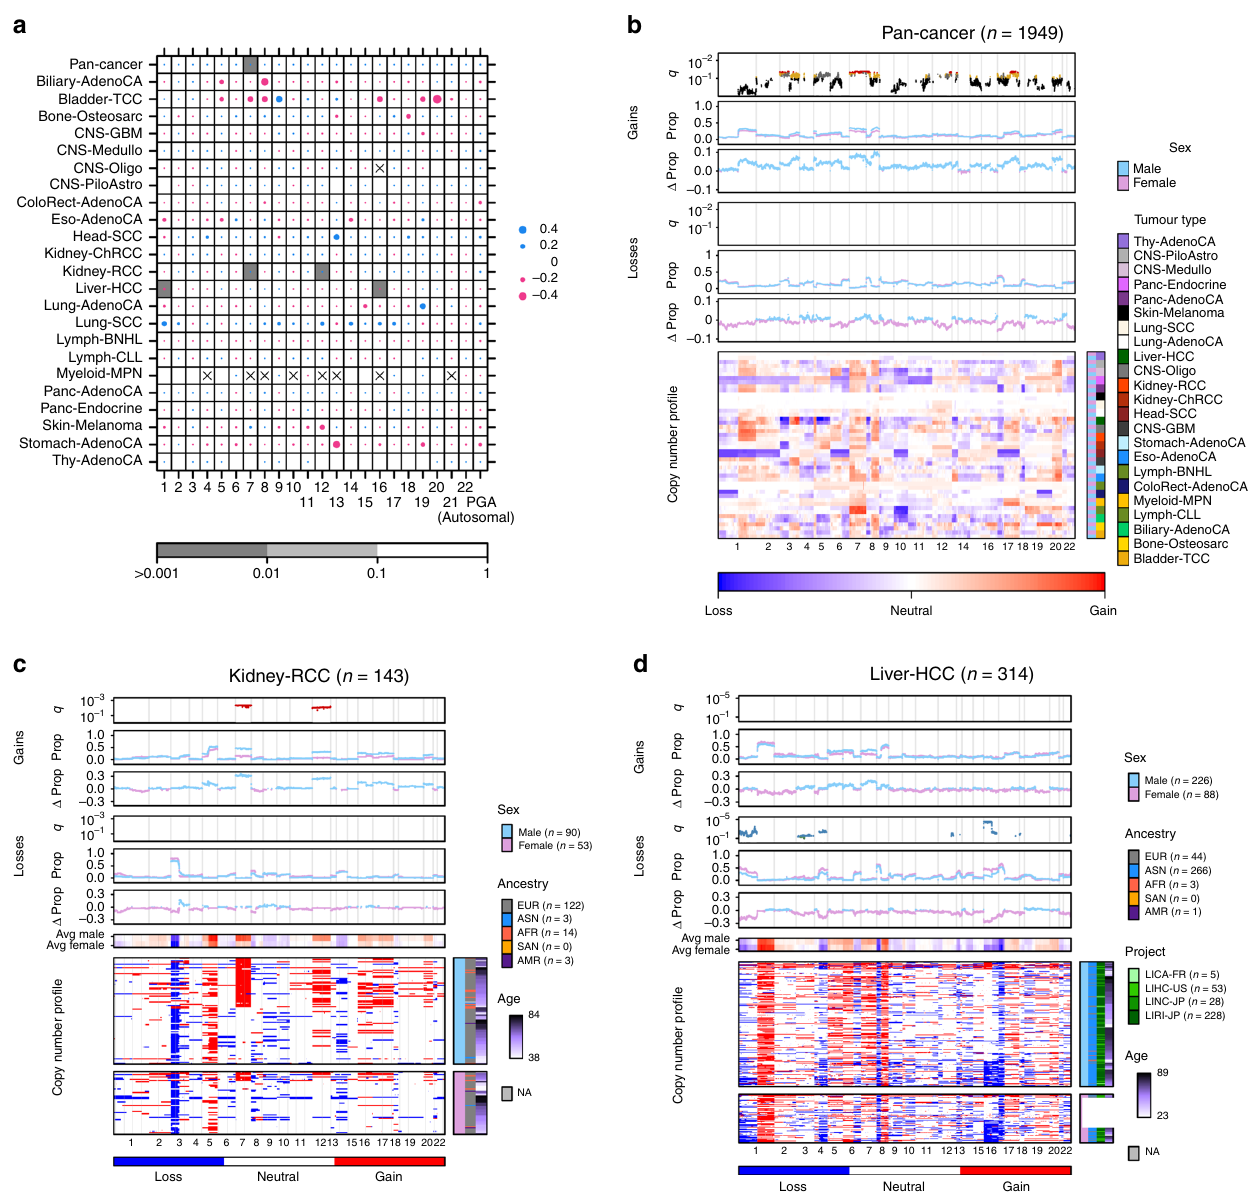
Fig. 2 Sex-biases in percent chromosome altered are re fl ected in gene-speci fi c events. a A summary of associations between sex and genome instability across tumour subtypes. Dot size shows difference in median percent genome altered or percent chromosome altered between the sexes. Dot colour shows direction of bias, with blue indicating higher instability in male-derived tumours and pink indicating higher instability in female-derived tumours. Background shading shows q -values from multivariate linear regression. Sex differences in CNAs for b pan-cancer, c kidney renal cell cancer, and d hepatocellular cancer. Each plot shows, from top to bottom: the q -value showing signi fi cance of sex from multivariate linear modelling with yellow/green points corresponding to 0.1 < q < 0.05, deep blue/red points corresponding to q < 0.05, and grey points indicating hits that were attributed to covariate sample size imbalances and rejected; the proportion of samples with aberration; the difference in proportion between male and female groups for copy number gain events; the same repeated for copy number loss events; and the copy number aberration (CNA) pro fi le heatmap. The columns represent genes ordered by chromosome. Light blue and pink points represent data for male- and female-derived tumours